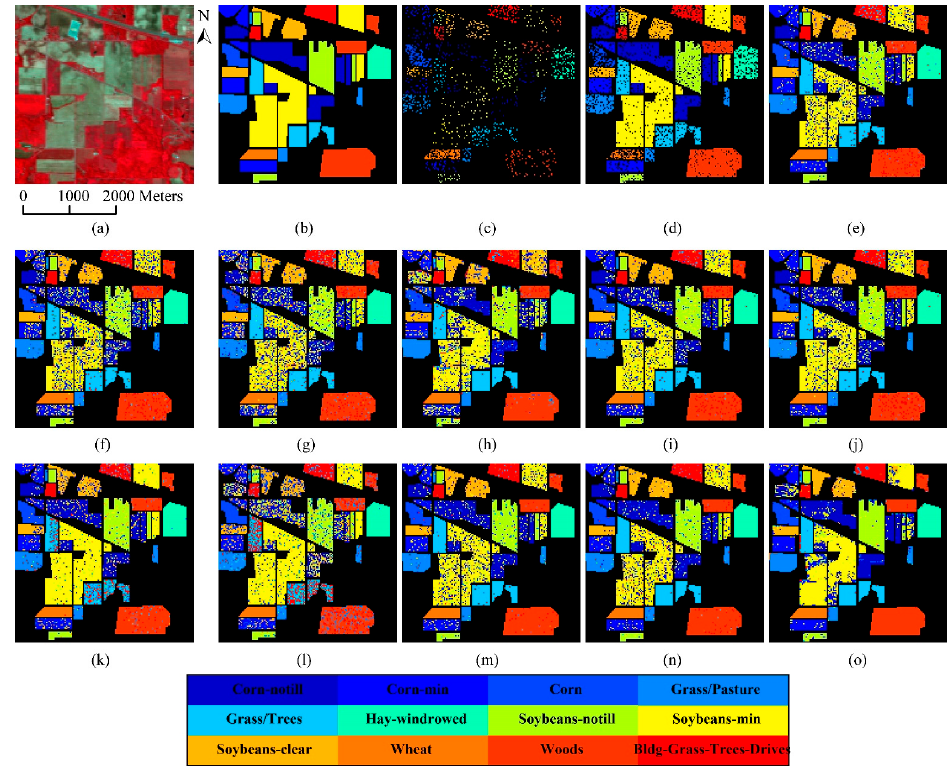
Figure 5. Classification maps generated with 120 training samples per class on the Indian Pines image.